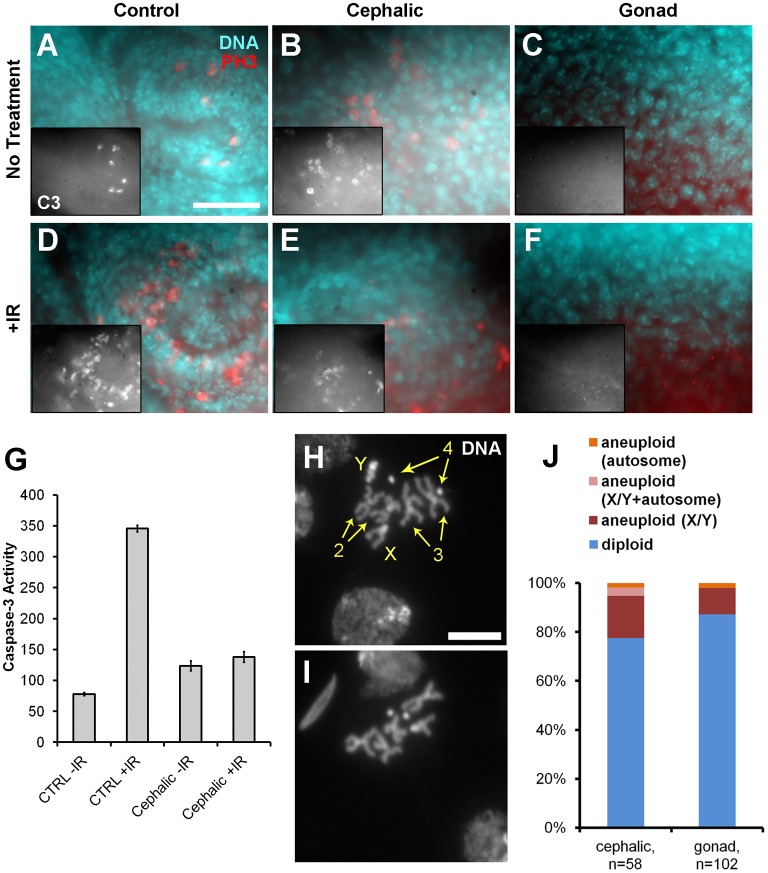
Cephalic and gonad neoplasms show resistance to IR-induced apoptosis and increased aneuploidy.(A–F) Larvae were dissected 4 hour after irradiation with 4000 R of X-rays 4 hour, fixed, and stained DNA (blue) and with an antibody to activated caspase-3 (C3, red). (A,D) From wild-type imaginal wing discs in larvae with cephalic neoplasms. (B,C,E,F) From cephalic and gonad neoplasms. We examined between 5 and 10 cephalic and gonad neoplasms with the same trend of high and low basal apoptosis, respectively. Insets in panels A–F show caspase-3 only images. (G) Activated caspase-3 levels were measured in control tissues and cephalic neoplasms using an in vitro caspase-3 activity assay. Units are in fluorescence and normalized to the protein levels in each lysate. (H,I) Examples of chromosomes from gonads stained for DNA. Four pairs of Drosophila chromosomes are indicated in panel H. Panel I is missing a sex chromosome. (J) Aneuploid mitoses are expressed as % of total. The difference between cephalic and gonad neoplasm is not significant (P = 0.12, 2-tailed Fisher's exact test). Scale bar: 10 μm (A,H; also applies to B–F,I).